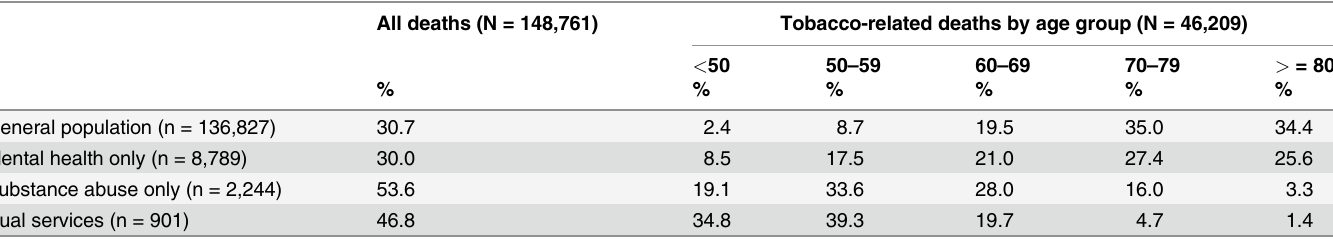
Table 3. Tobacco-related deaths for persons receiving mental health and/or substance abuse services in Oregon State, 1999 – 2005 (N = 148,761) * .